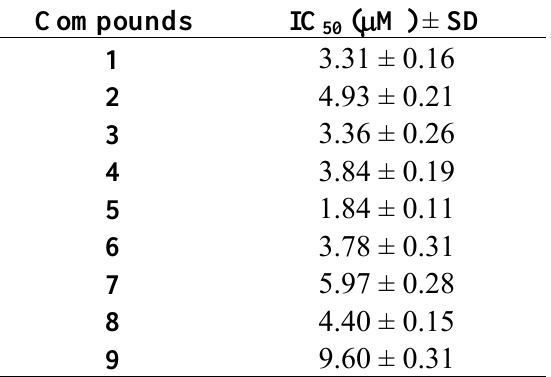
Table 1. In vitro cytotoxicity of curcuminoids 1-3 and curcuminoid-succinate prodrugs 4 -